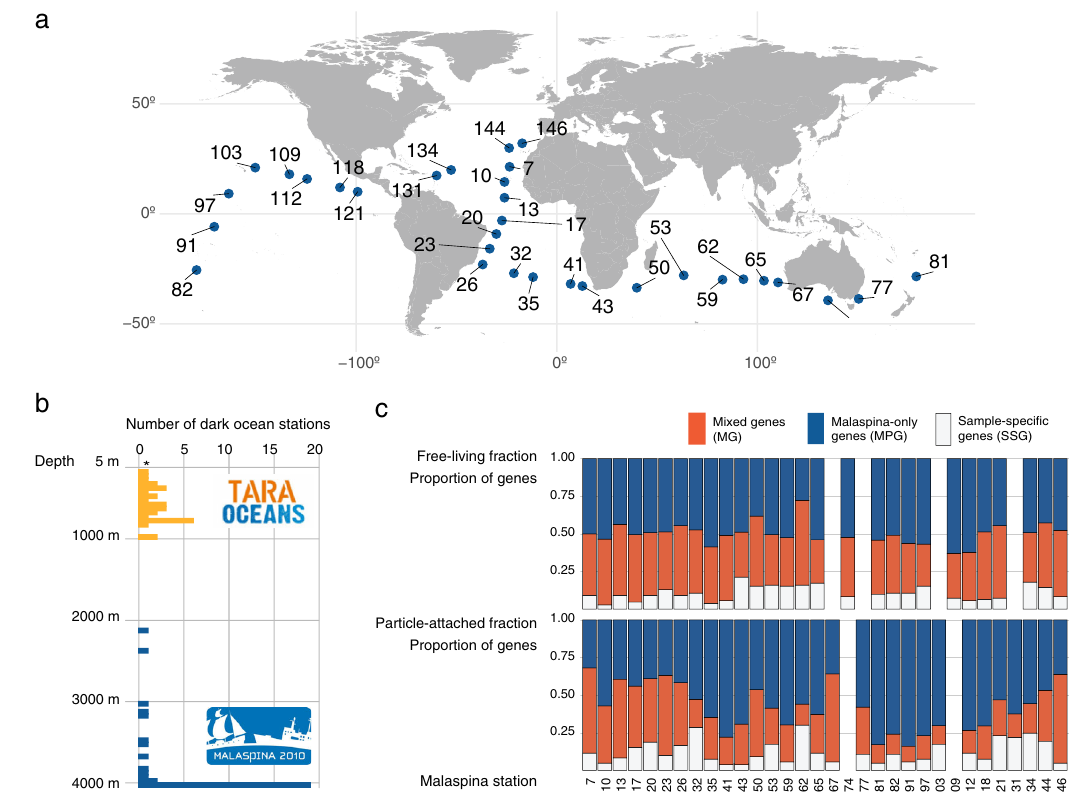
Fig. 1 Malaspina Deep Ocean Genetic Resources. a Malaspina 2010 expedition cruise track showing the locations of the 32 stations sampled for the present study. b Representation of the sampling depth and metagenomics dataset generated by the Tara Oceans and Malaspina 2010 Circumnavigation Expeditions. The histogram plot displays the number of stations sampled in the dark ocean during the Tara Oceans (orange) and Malaspina 2010 (blue) expeditions and the distribution by water depth. The Malaspina Gene Database (M-GeneDB) was generated from the integration of 58 metagenomic bathypelagic samples. The asterisk in the histogram indicates the samples collected in the photic layer in Tara Oceans that were not included in the fi gure. c Analyses of the integrated gene catalog that results from the Tara Oceans (OM-RGC.v2) and M-GeneDB. The relative abundance of unique genes that appear only in Malaspina (MPG) (solid blue), Mixed genes (MG) that are present in both catalogs (red), and the Malaspina Sample-Speci fi c genes (SSG) in white for both the free-living (FL; 0.2 – 0.8 µ m) and particle-attached (PA; 0.8 – 20 µ m)